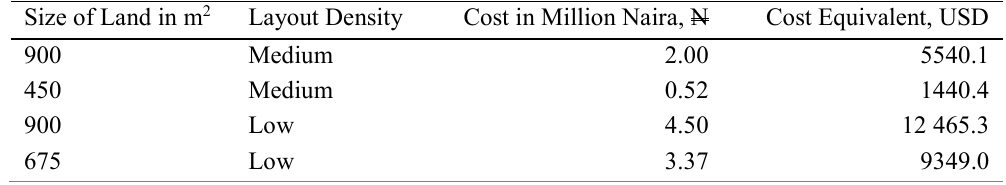
Table 4 . Cost of Residential Plots of Land in Jos